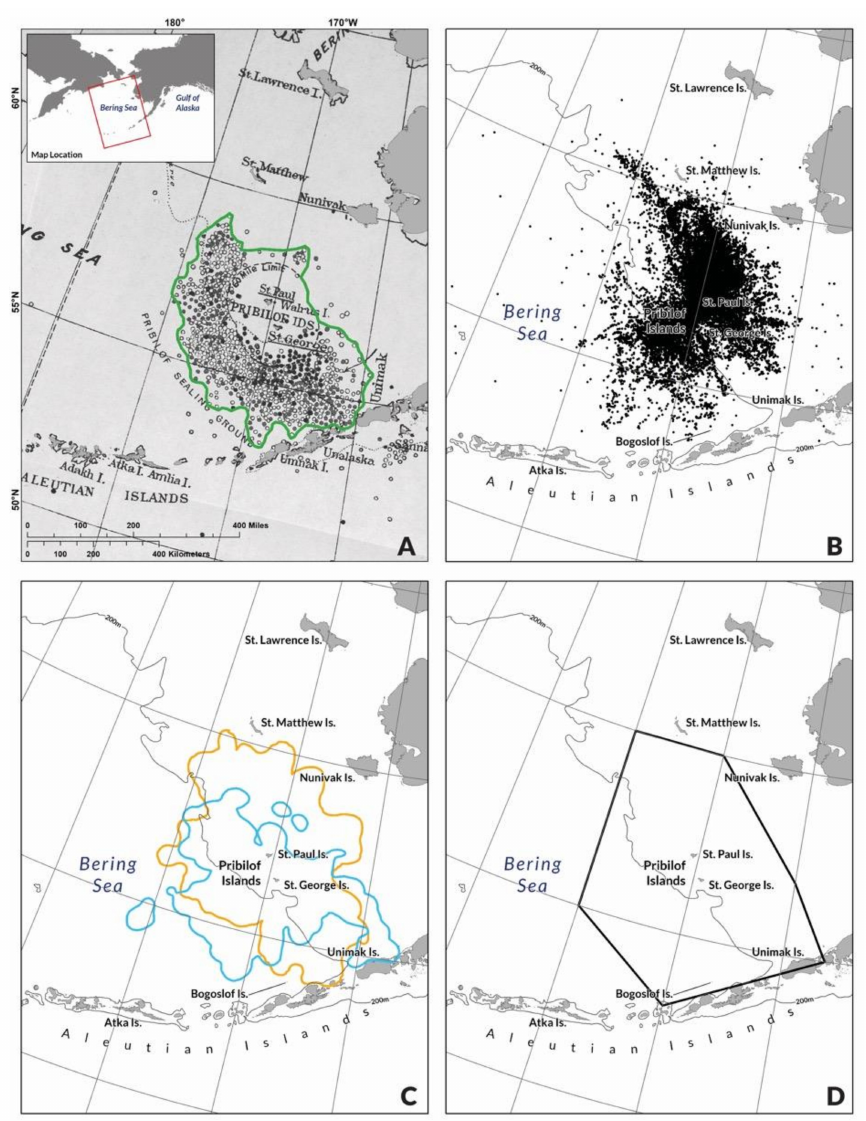
Figure 1. ( A ) Pelagic sealing takes in the Pribilof region from 1883 to 1897 based on logbooks from 123 pelagic sealing vessels [25]. Green line encompasses 95% of Bering Sea records. ( B ) Telemetry- derived foraging locations of lactating female fur seals from St. Paul ( n = 20) in the summer of 2005 and 2006 [26]. ( C ) Meta-home ranges of telemetry-tagged lactating female fur seals from St. Paul and St. George Islands in 1995 and 1996 (yellow boundary; n = 97) [27] and St. Paul Island in 2009 (blue boundary; n = 82) [28]. ( D ) Simple polygon of female northern fur seal summer foraging habitat that encompassed 95% of data sources (area = 385,300 km 2